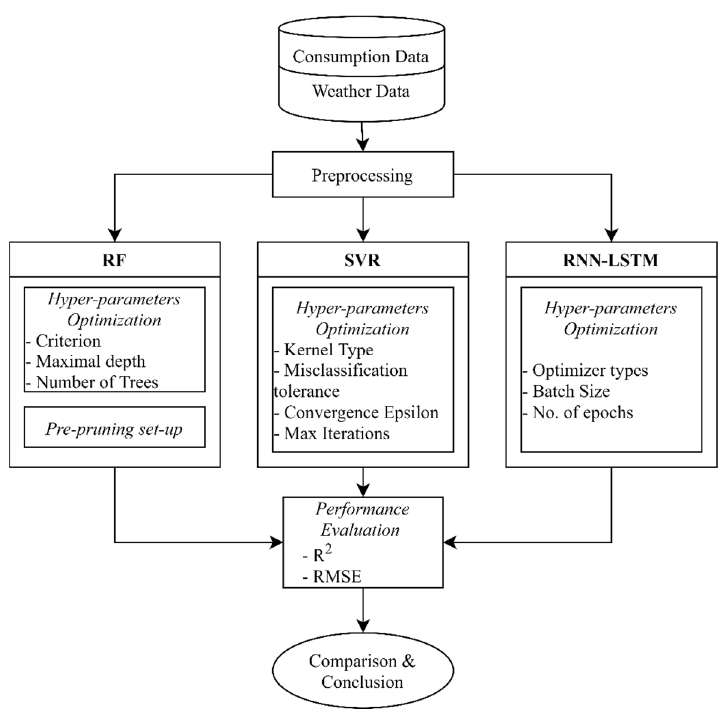
Figure 1. High-level methodology of this study.